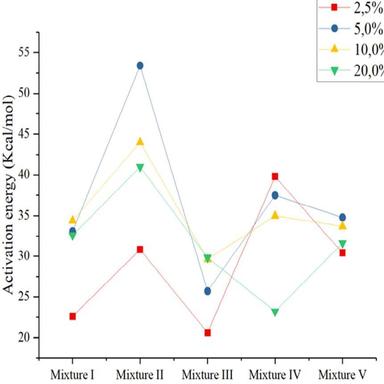
Activation energy plot for each mixture at the 2.5% 5%, 10% and 20% degradation levels.